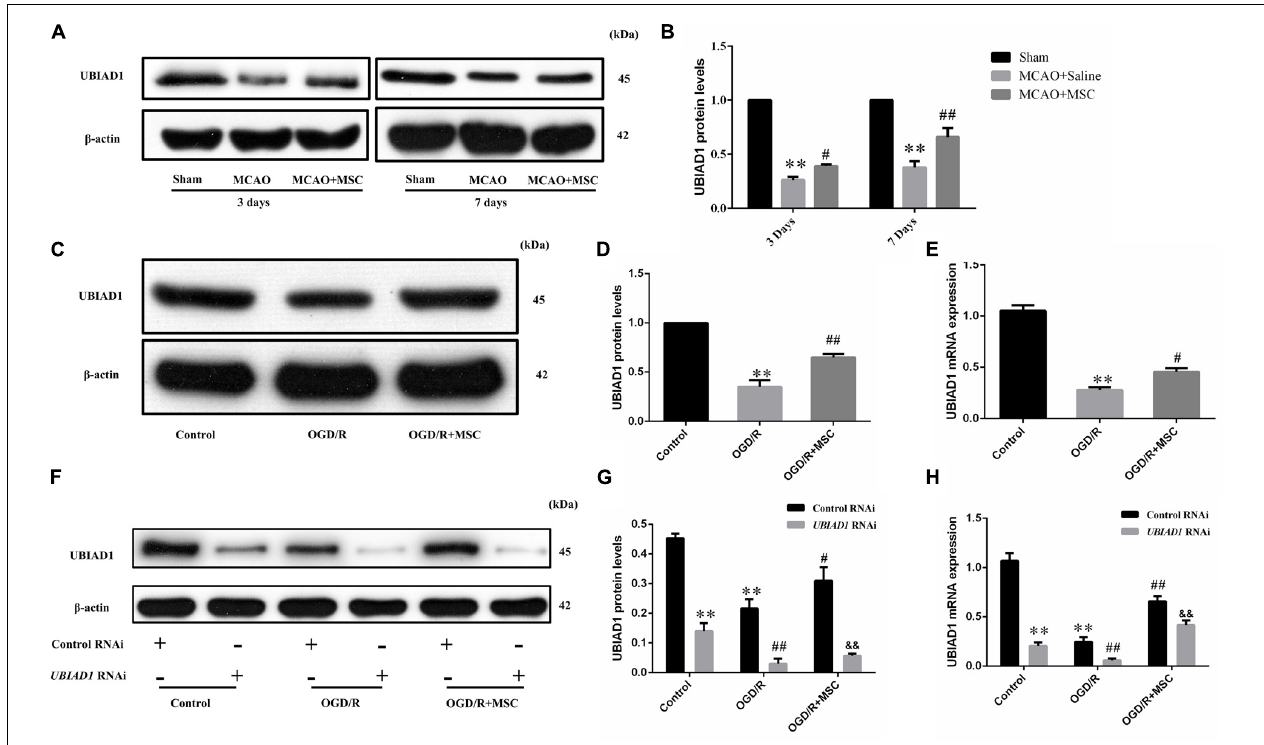
FIGURE 5 | Expression of UBIAD1 upregulated by OM-MSC treatment. (A,B) The protein expression of UBIAD1 in the peri-infarct cortex was detected using Western blotting. Data are displayed as mean ± SEM ( n = 3). ( ∗ P < 0.05, ∗∗ P < 0.01 vs. sham-operated, # P < 0.05, ## P < 0.01 vs. MCAO + saline.) (C,D) The protein expression of UBIAD1 in the N2a cells was detected using Western blotting. (E) The mRNA expression of UBIAD1 in the N2a cells was detected by qPCR. Data are displayed as mean ± SEM ( n = 3). ( ∗ P < 0.05, ∗∗ P < 0.01 vs. control, # P < 0.05, ## P < 0.01 vs. OGD/R.) (F–H) Representative expression of UBIAD1 after transfection with siRNA. Data are displayed as mean ± SEM ( n = 3). ( ∗∗ P < 0.01 vs. Con/control RNAi, # P < 0.05, ## P < 0.01 vs. OGD/R/control RNAi, && P < 0.01 vs. OGD/R + MSCs/control